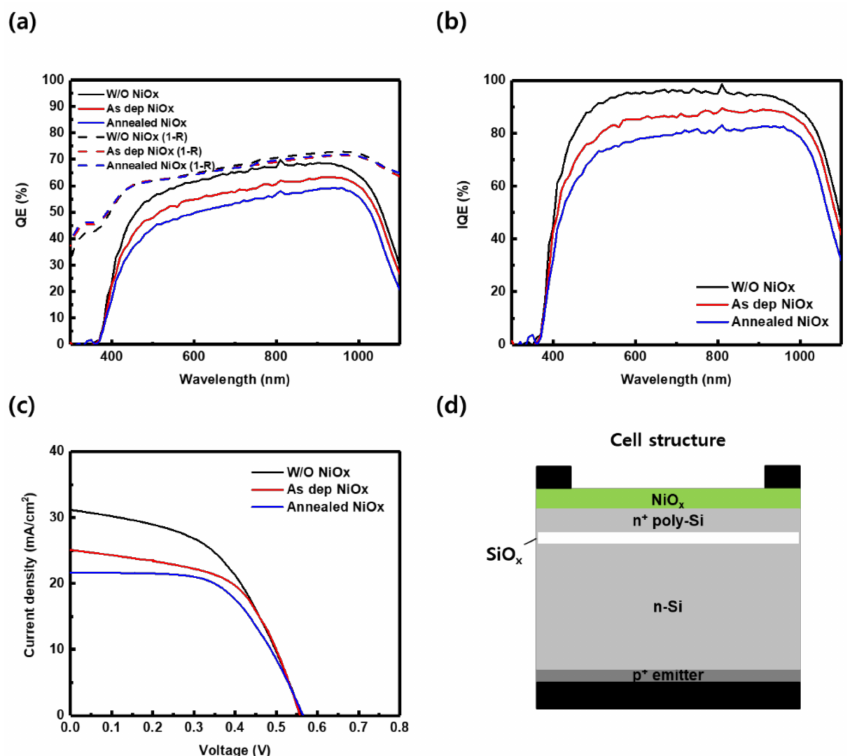
Figure 9. ( a ) External quantum efficiency (EQE); ( b ) internal quantum efficiency (IQE); ( c ) light current density-voltage (LJV) characteristics; ( d ) schematic structure of the NiO x /TOPCon bottom